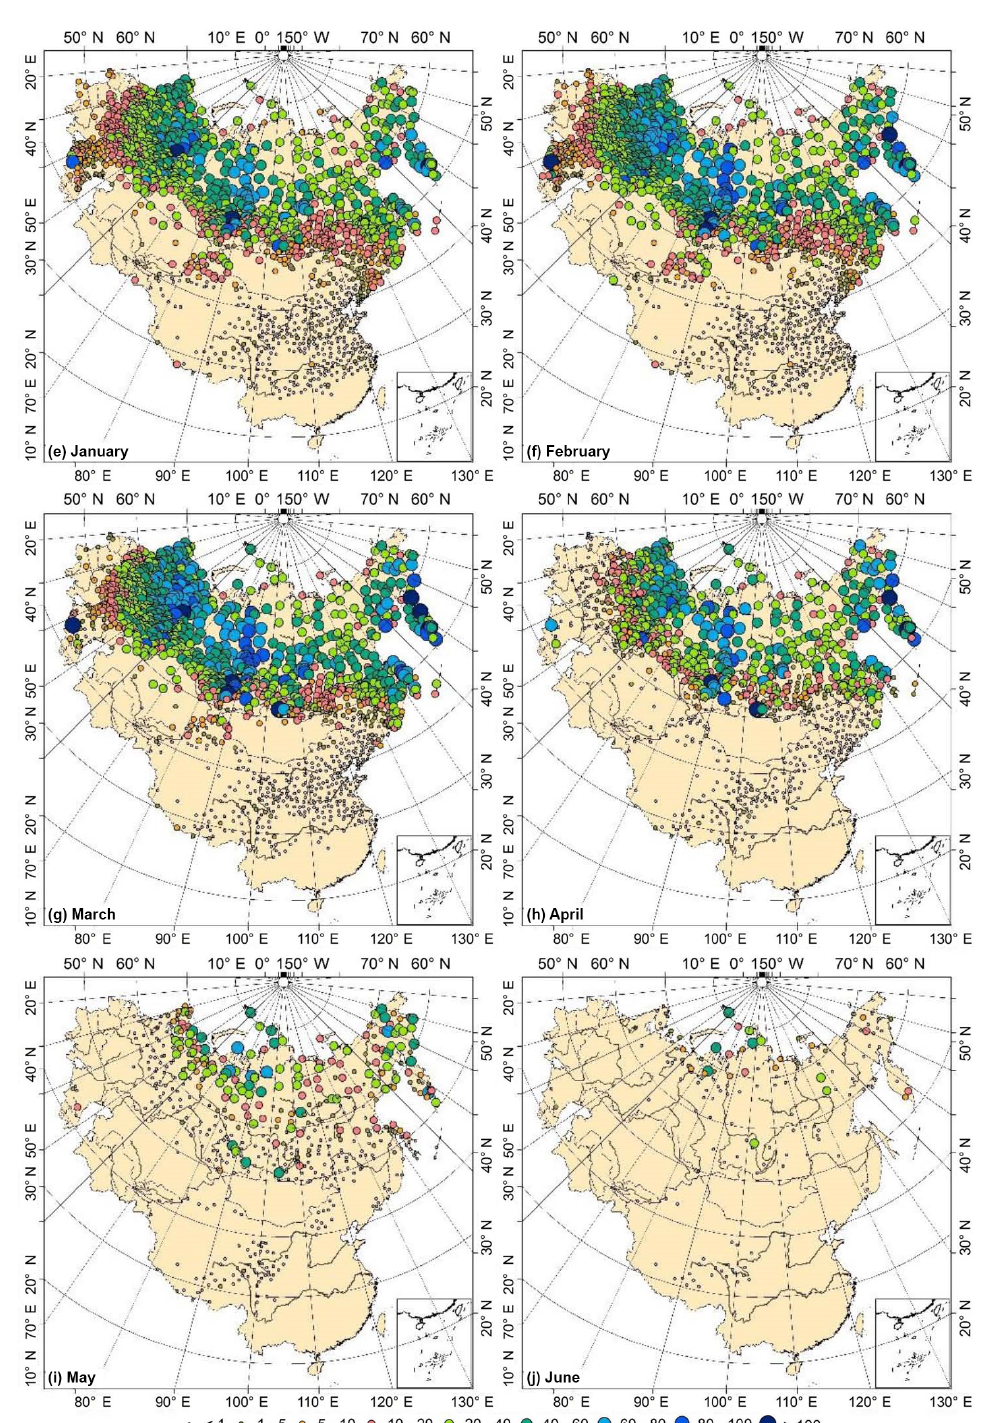
Figure 3. Long-term mean monthly snow depth (from September to June; in centimeters) across the Eurasian continent during the 1971– 2000 period. (a) September. (b) October. (c) November. (d) December. (e) January. (f) February. (g) March. (h) April. (i) May. (j)